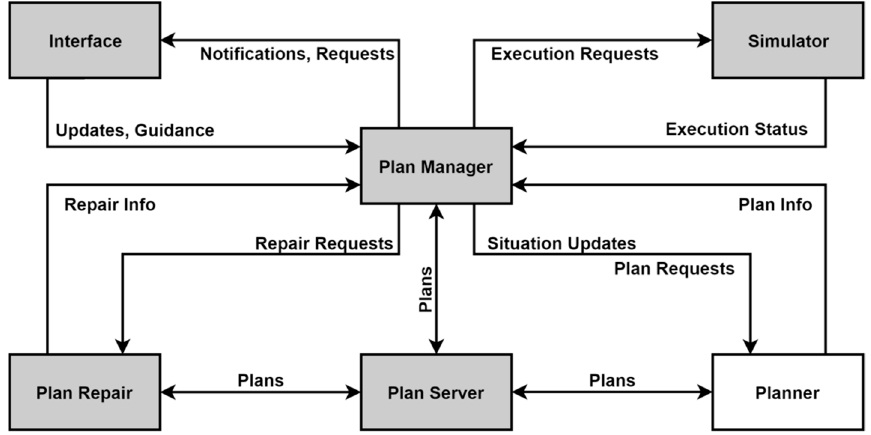
Figure 18. Functional overview of CPEF.